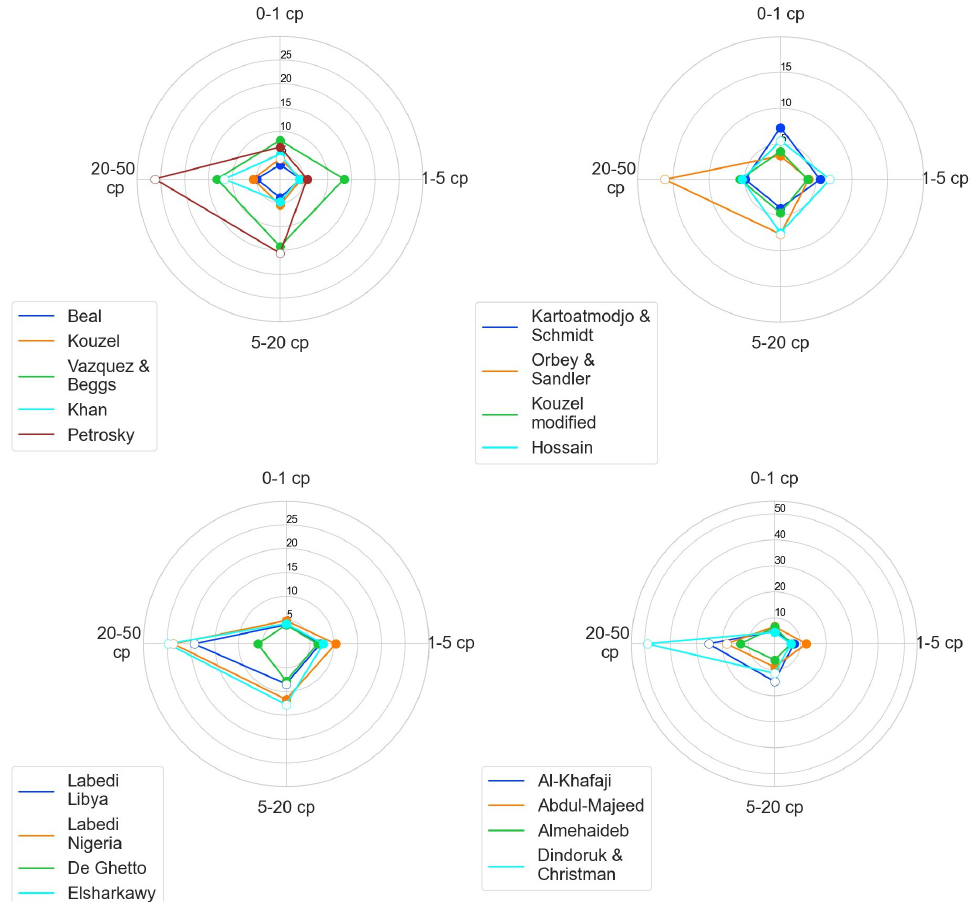
Figure 8. AARE radar charts of the correlations in all four clusters (hollow points correspond to results obtained outside the development range of the